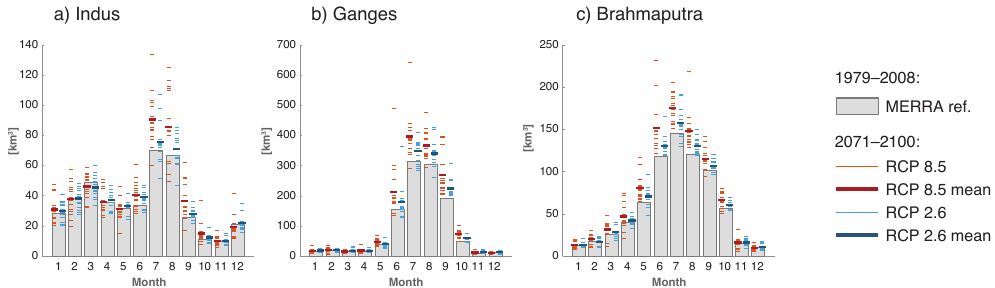
Figure 9. Projected future precipitation in the (a) Indus, (b) Ganges and (c) Brahmaputra basins. Gray bars indicate MERRA 1979–2008. Thin lines and horizontal marks on the bars show the individual CMIP5 models and the multi-model mean for 2071–2100.